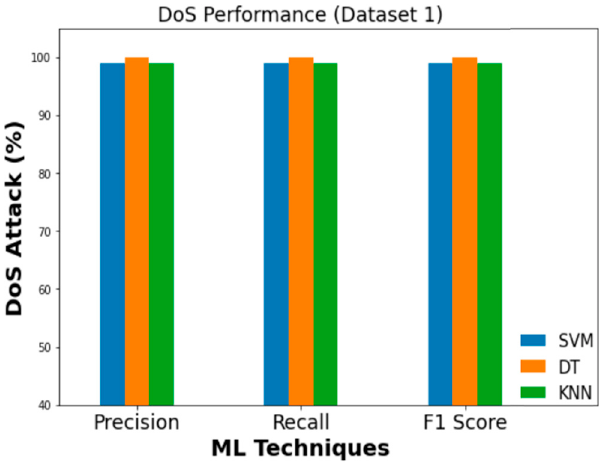
Figure 16. Performance evaluation metrics (DoS).